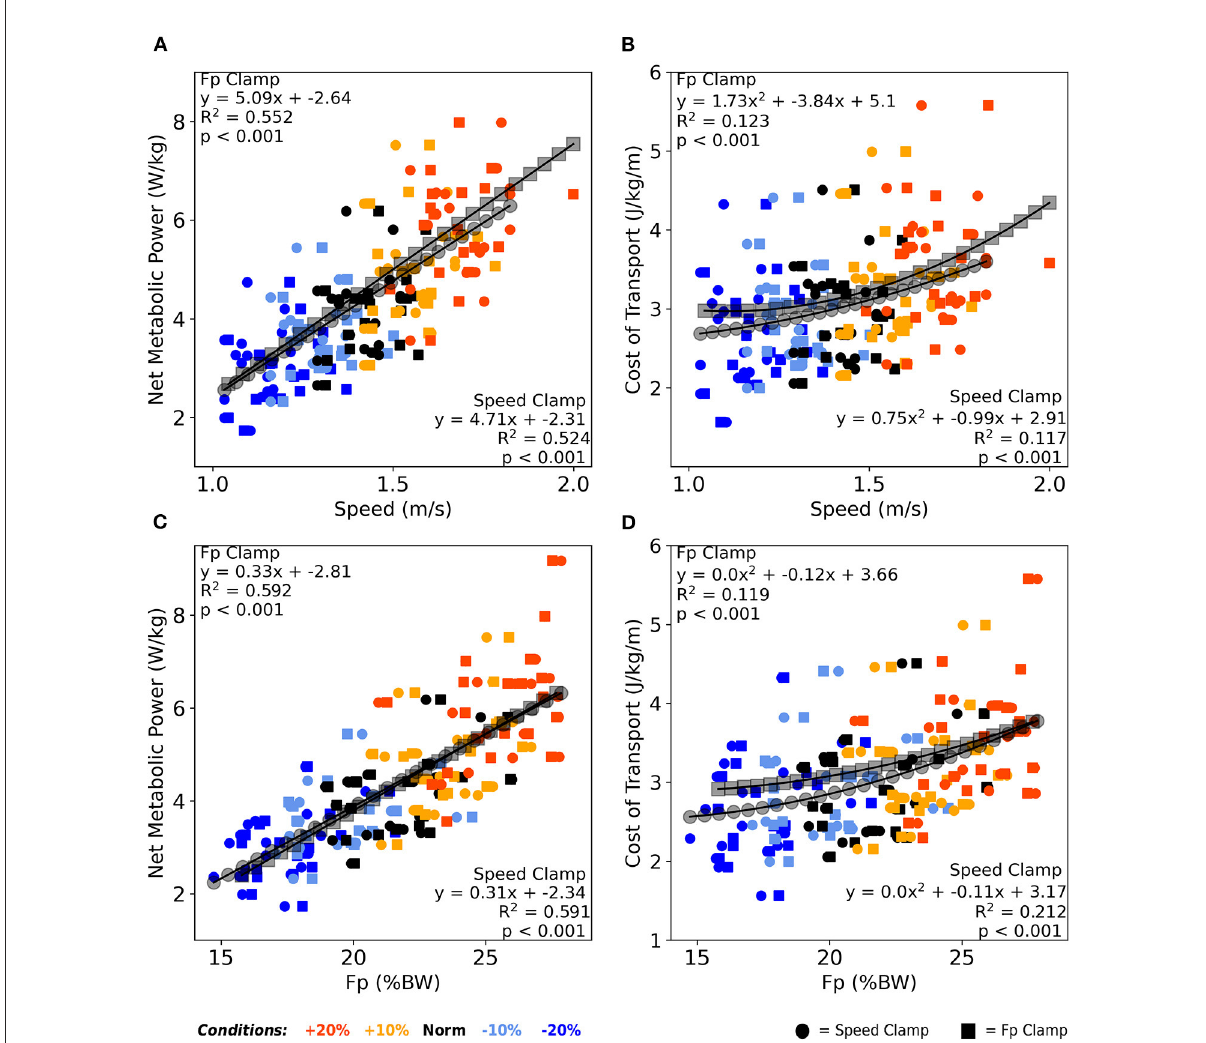
FIGURE5 Averaged over the final 2min, both walking speed (A) and F P (C) correlated moderately with net metabolic power across both clamp types. Similarly, both walking speed (B) and F P (D) correlated very weakly with cost of transport across both clamp types. Once again, participants responded nearly identically between clamp types across these four relations as well as between walking speed and F P in the context of metabolic cost. BW, body